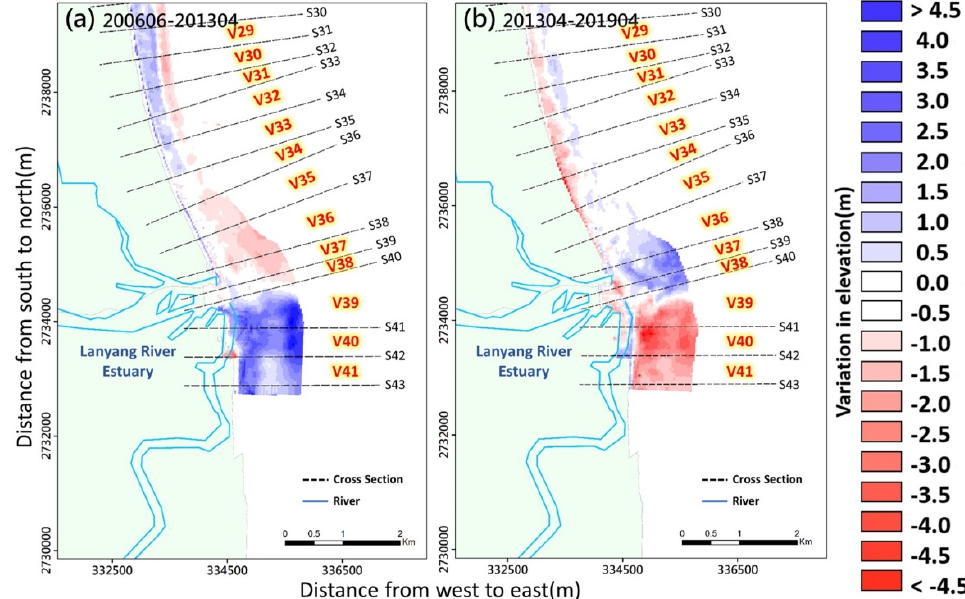
Figure 12. Long-term erosion and accretion and spatial distribution of the cross sections for sampling bathymetry near the Lanyang River estuary during the period of ( a ) June 2006 to April 2013 and ( b ) April 2013 to April 2019.